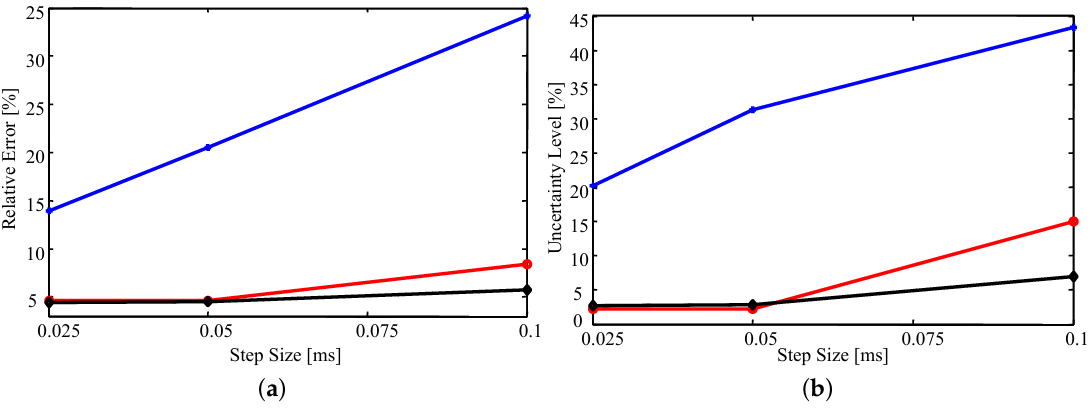
Figure 8. The average ( a ) relative error and ( b ) relative uncertainty of the estimates as a function of time step size for various triangulations. Blue with the plus markers: 172 elements; red with circle markers: 205 elements; black with diamond markers: 263